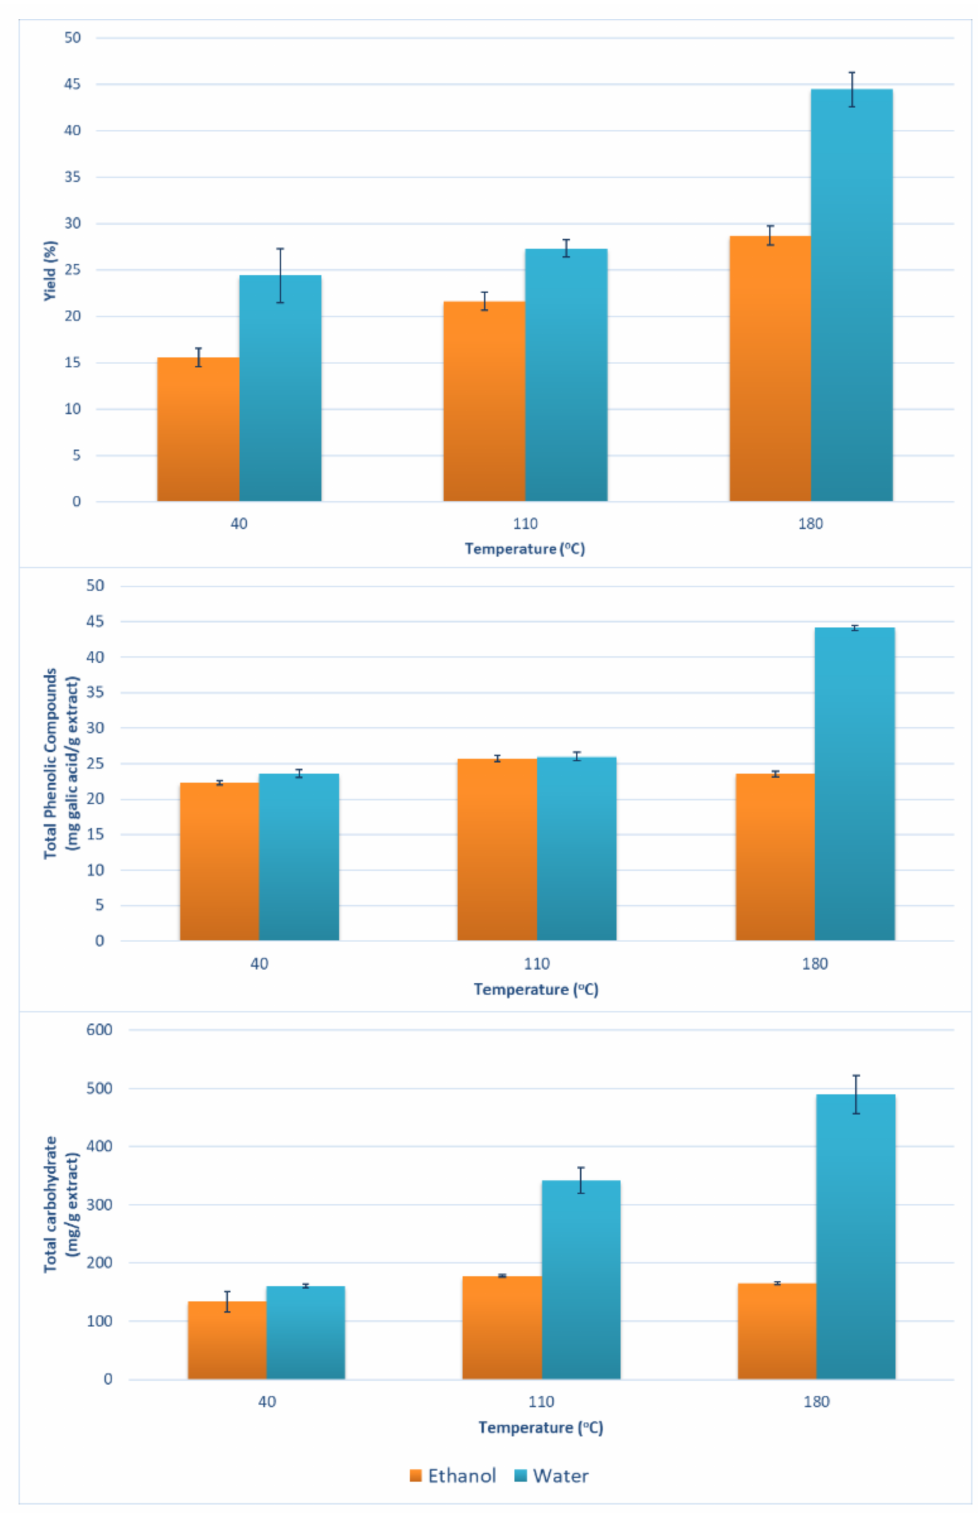
Figure 2. Extraction yield, total Phenolics (mg GAE/g extract) and total carbohydrates (mg/g extract) determined in the extracts of Ammodaucus leucotrichus obtained using 10 min pressurized liquid extraction at the indicated